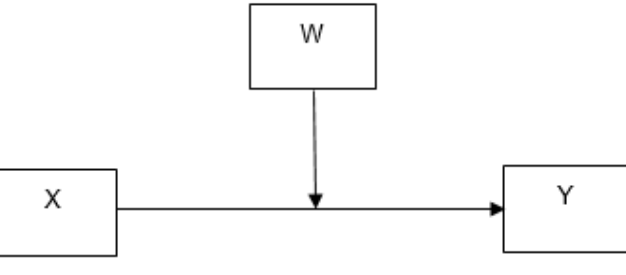
Figure 1. Conceptual model with a single moderator.